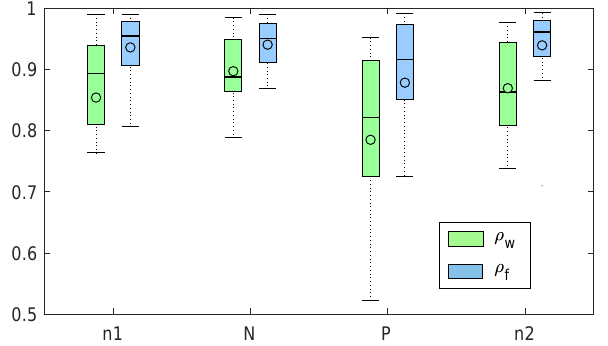
Figure 4. Boxplots related to ρ f (blue) and ρ w (green) values corresponding to the four experimental sessions (n1, N, P,